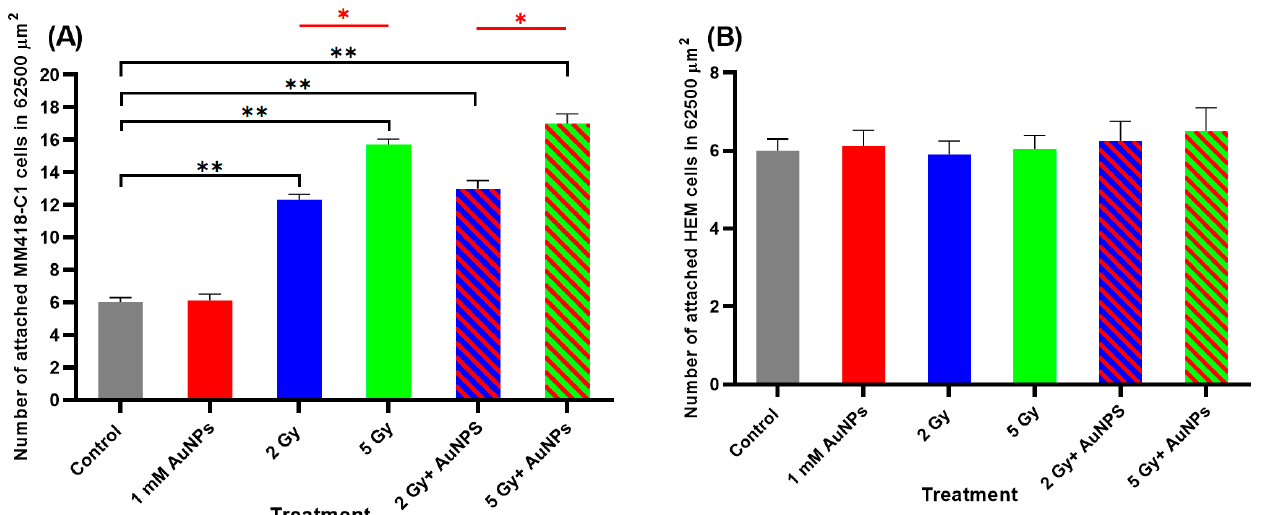
Figure 9. Effect of AuNPs and/or IR on the adhesion of ( A ) MM418-C1 and ( B ) HEM cells in Vitro. Cells were treated with 1 mM AuNPs 24 h and/or 2 and 5 Gy (6 MV X-rays) and after 24 h the cells were trypsinised and plated in 6-well plates. After 4 h, the number of adhered cells in a 62,500 µm 2 area were counted. Results are expressed as the mean ± SEM of 3 replicates. Significance of different treatments compared to the untreated control is represented by black lines shown as ** p < 0.01 and red lines shown as * p < 0.05.